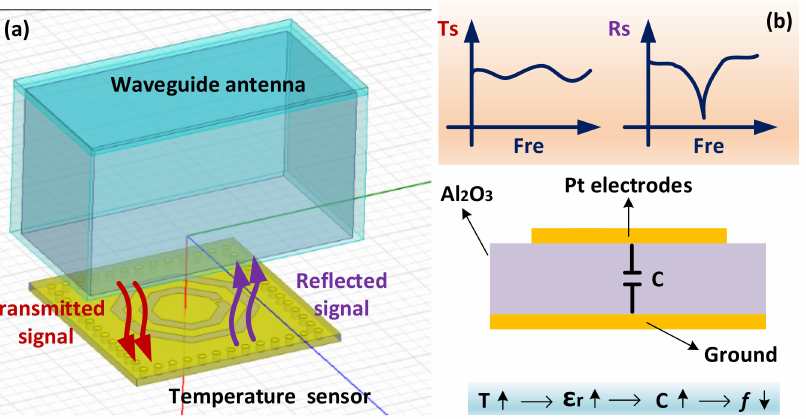
Figure 2. Wireless sensing mechanism of the sensor. ( a ) Transmission principle. ( b ) Working principle of the